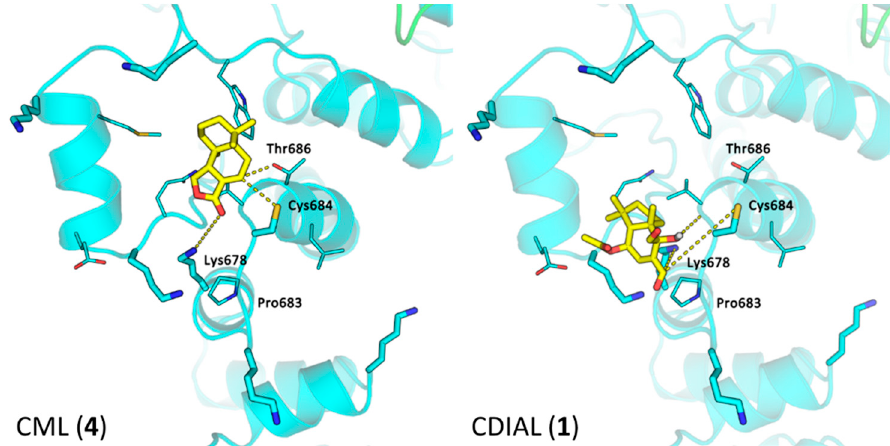
Figure 6. Structural models of CML ( 4 ) or CDIAL ( 1 ) in the putative CDIAL-binding site of AgTRPA1. Potential interactions between ligand (yellow) and residues of AgTRPA1 (cyan) as predicted by computational docking are shown. Several nearby residues are labeled and shown in licorice representation.